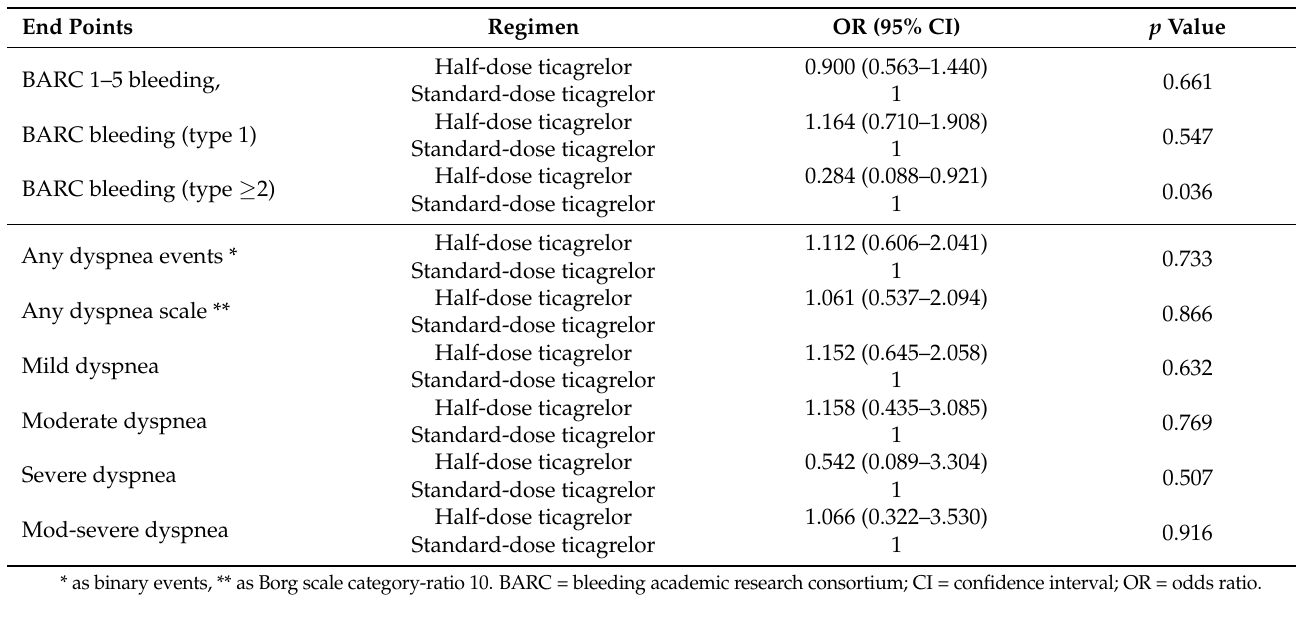
Table 2. Comparisons of primary and secondary endpoints in half vs. standard-dose ticagrelor during 6 months.